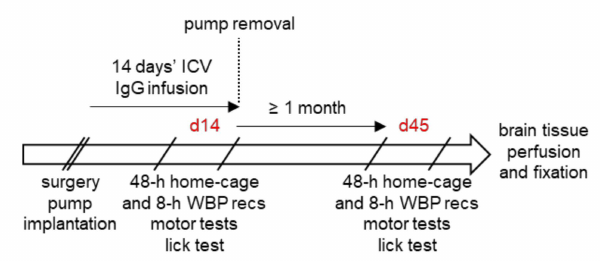
Figure 1. Schematic of the experimental protocol. ICV: intracerebroventricular. IgG: G immunoglob- ulin. WBP: whole-body plethysmograph. Recs: recordings. The two phenotyping rounds were performed at the end of the 14-day ICV antibody infusion (d14) and at least 1 month after the end of the infusion (d45). Surgery and pump implantation was performed in mice at 19–22 weeks of